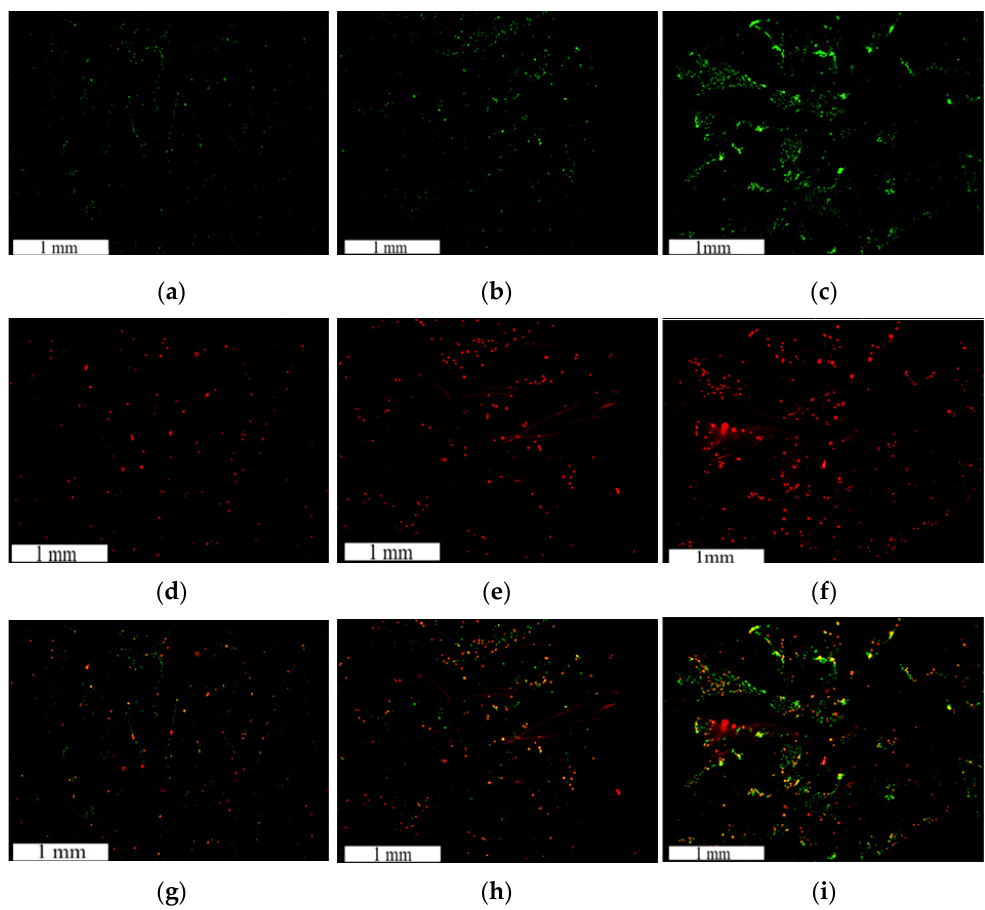
Figure 8. NucSpot 470 ® cell adhesion Stain (Green-( a – c) ), BaseClick™ 594-EdU cell proliferation stain (Red-( d – f) ), and combined imaging ( g – i ) results for endothelial cells seeded on PCL FDS samples incubated for 24-h ( a , d , g ), 36-h ( b , e , h ), and 48-h ( c , f , i ).